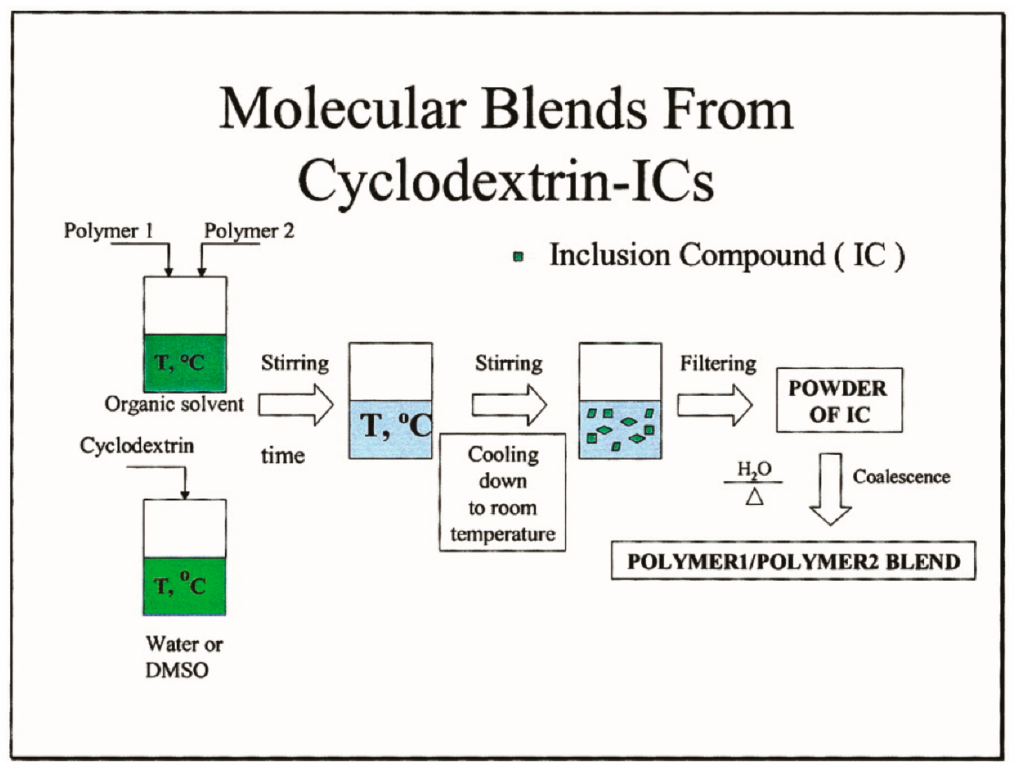
Figure 8. Schematic depiction of the formation of polymer1 / polymer2 blends via coalescence from their common CD–ICs. Reproduced with permission from [28]. Copyright 2004 Wiley Periodicals,